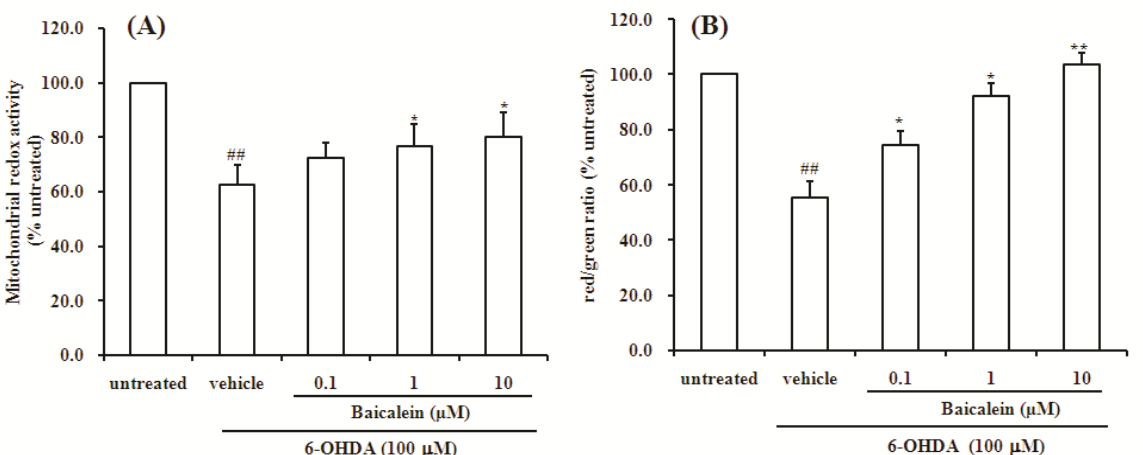
Figure 3. Effect of baicalein on mitochondrial redox activity and mitochondria membrane potential of SH-SY5Y cells induced by 6-OHDA. ( A ) Mitochondrial redox activity was assayed by resazurin; ( B ) Mitochondria membrane potential was assayed by JC-1 staining. Data were expressed as percentage of untreated